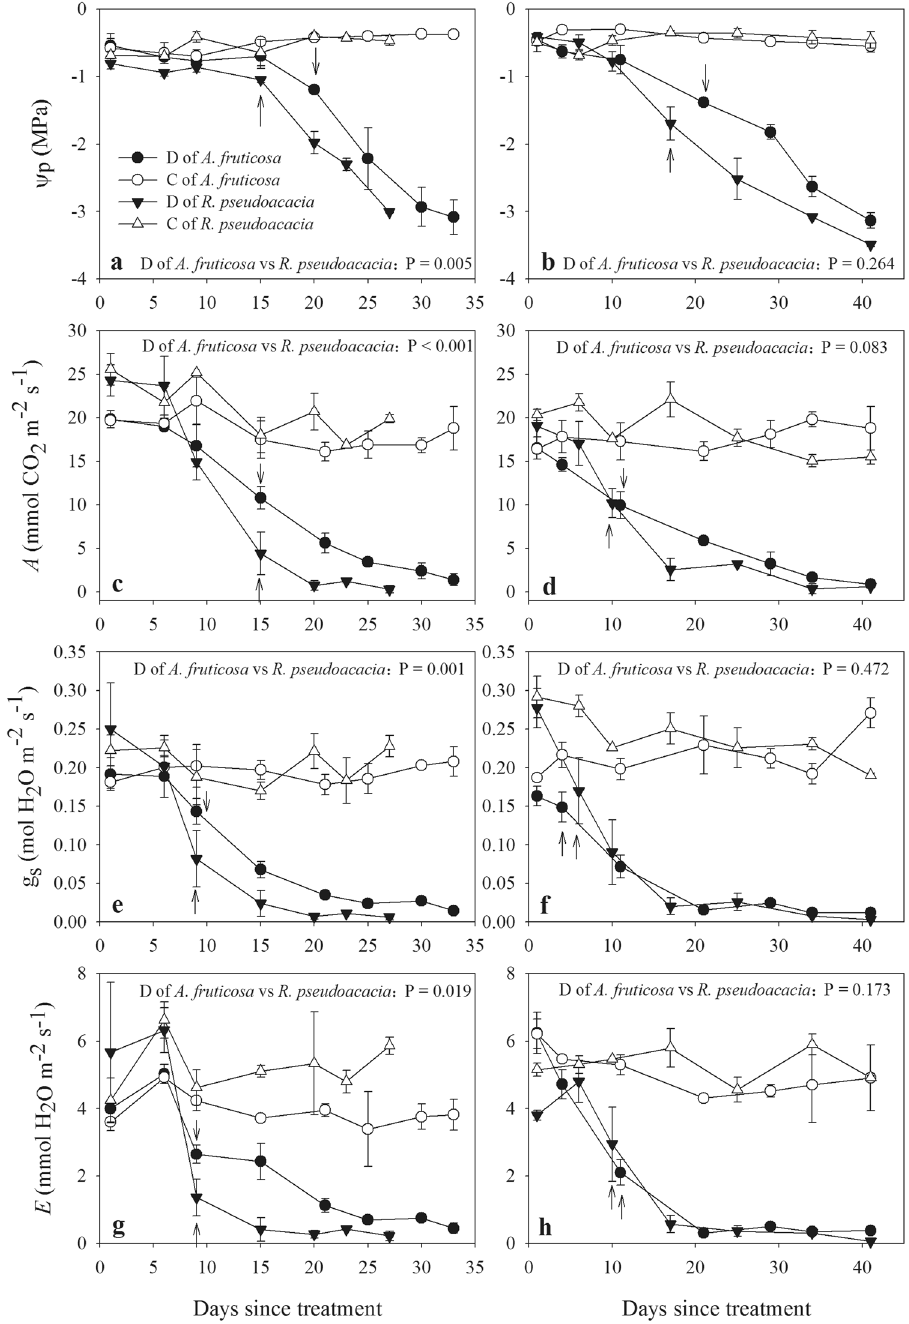
Figure 1. Comparison of pre-dawn leaf water potential ( Ψ p ), net photosynthesis ( A ), stomatal conductance (g s ) and leaf transpiration ( E ) during drought cycles 1 ( a , c , e , g ) and 2 ( b , d , f , h ) between A. fruticosa and R. pseudoacacia . Panels c and d in graphic symbols represent plants in the control and drought groups, respectively; the arrow indicates the threshold of statistical significance at P < 0.05 between the drought and control plants of both species, and the error bars represent standard error, n =